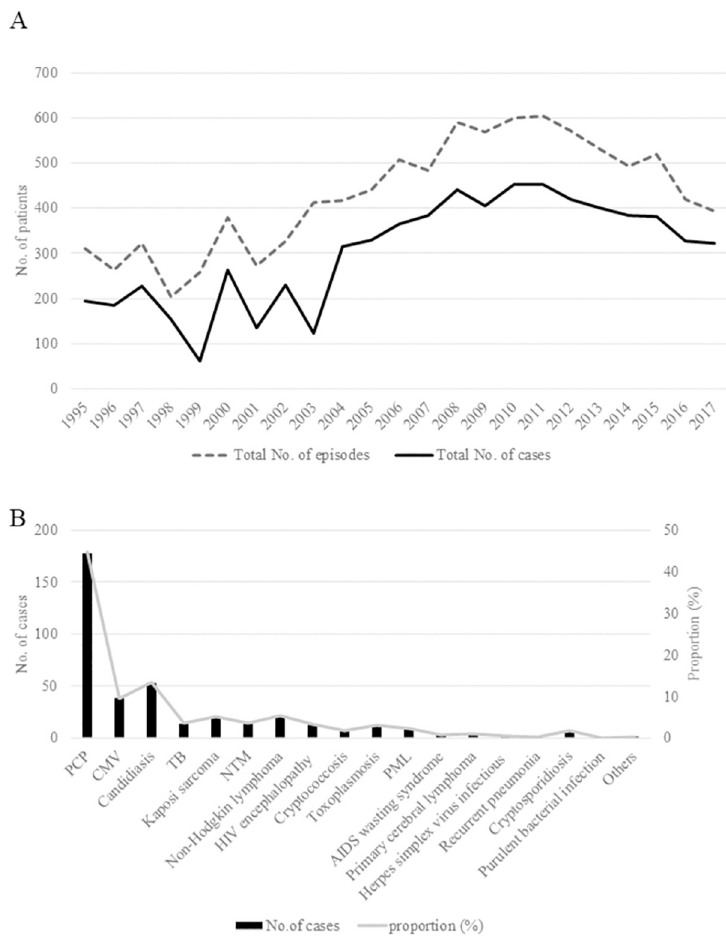
Fig 1. Incidence trends of acquired immunodeficiency syndrome (AIDS)-defining illnesses (ADIs). (A) Change in the number of reported cases of ADIs over time (based on the questionnaire sent to human immunodeficiency virus [HIV]/AIDS referral hospitals across Japan). The total number of patients and episodes encountered in 2017 was 320 and 391, respectively. The numbers indicate a continuously decreasing trend since 2012. (B) Cumulative incidence and proportion of ADIs between 1995 and 2017. Pneumocystis pneumonia (PCP) occurred the most frequently, followed by cytomegalovirus (CMV) infection, candidiasis, tuberculosis (TB), Kaposi sarcoma, and non-tuberculous mycobacterial (NTM)